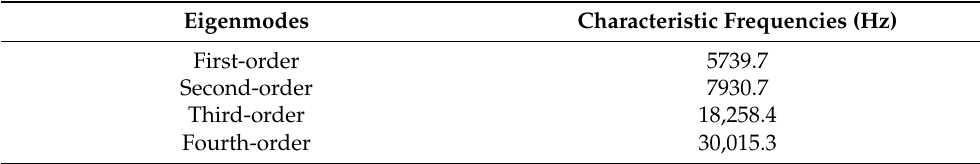
Table 4. The characteristic frequencies corresponding to the first four modes of the MEMS